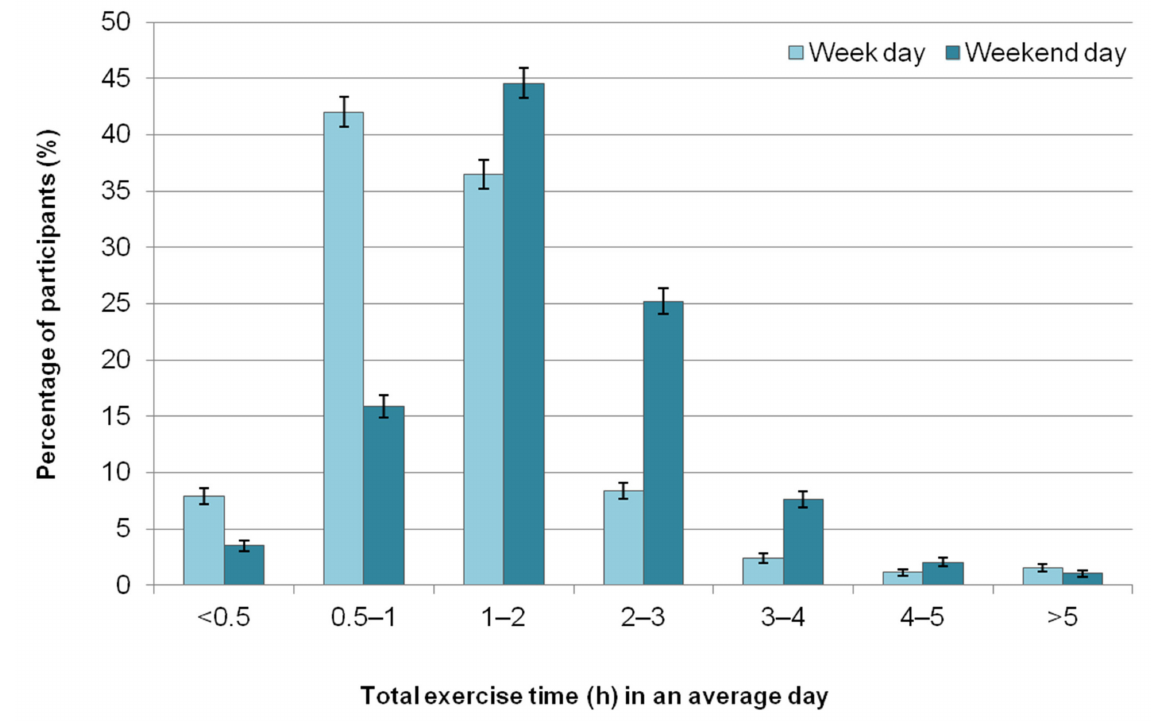
Figure 2. The total time (hours) spent exercising all horses owned/cared for on an average day as reported by UK equestrians ( n = 5424) for both weekdays (Monday to Friday) and weekend days (Saturday to Sunday). Most participants (84.4%) regularly exercised one or two horses. Error bars represent 95% confidence